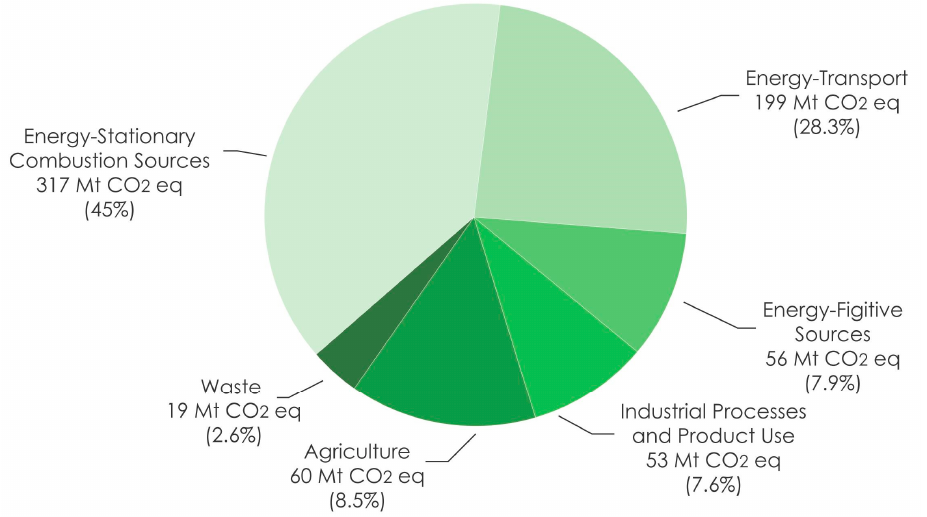
Figure 1. Breakdown of Canada’s emissions by the Intergovernmental Panel on Climate Change sector (2016) [3].